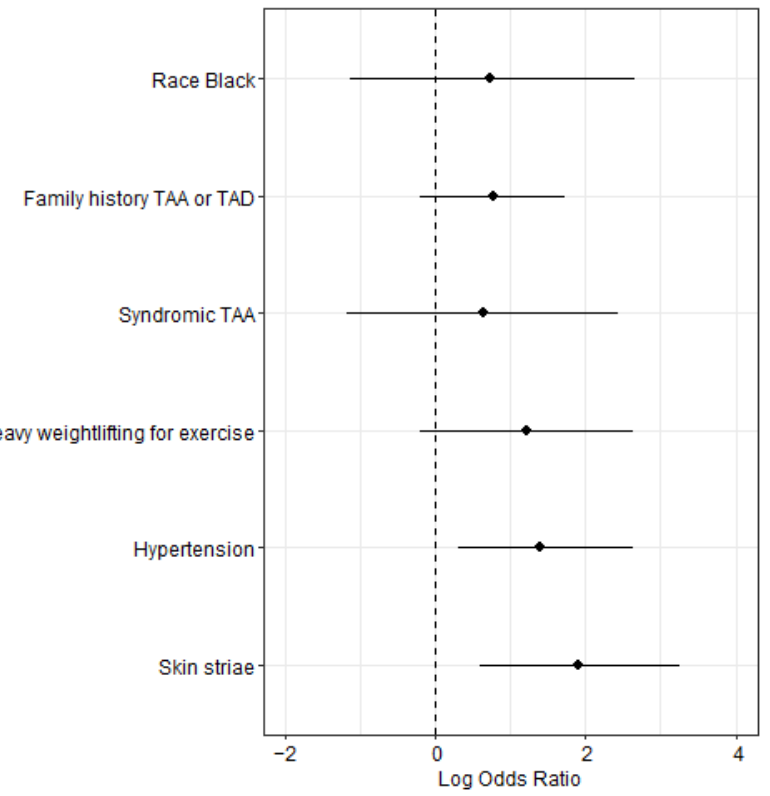
Figure 2. Result of multivariate analysis for characteristics associated with thoracic aortic dissection (TAD). Odds ratios are estimated through multivariate logistic regression model. Forest plot dis- plays log 2 of odd ratios (diamond) and 95% confidence intervals (bar). Skin striae ( p = 0.005) and hypertension ( p = 0.018) were independently associated with TAD. TAA: thoracic aortic aneurysm. Table 4. Comparison of total revised Ghent systemic points between thoracic aortic dissection (TAD) ( N = 70) and non-TAD ( N = 153) cases who lacked a diagnosis of a TAA-associated syndrome. Striae Included in Calculation of Points Striae Not Included in Calculation of